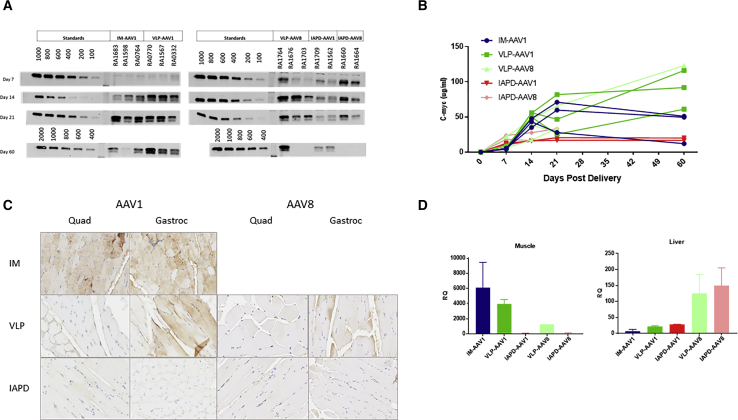
Serum AAT c-myc Expression, Muscle Immunohistochemistry for AAT, and RT-PCR(A) Western blot gel image for all time points (please note that several AAV8 day-60 samples were missing). (B) Semi-quantitation of western blot (WB) data represented as mean ± SEM. (C) Immunohistochemistry for AAT at day-60 representative sections for each dosing route for both AAV1 and AAV8. Muscle samples were collected for immunohistochemistry (IHC) from the level of the IM injections in both the quadriceps and gastrocnemius. (D) RT-PCR data from day-60 muscle and liver tissue. The gastrocnemius muscle samples were used for all groups. IM muscle samples were collected from the injection site. IM, intramuscular; IAPD, intra-arterial push and dwell; VLP, venous limb perfusion.